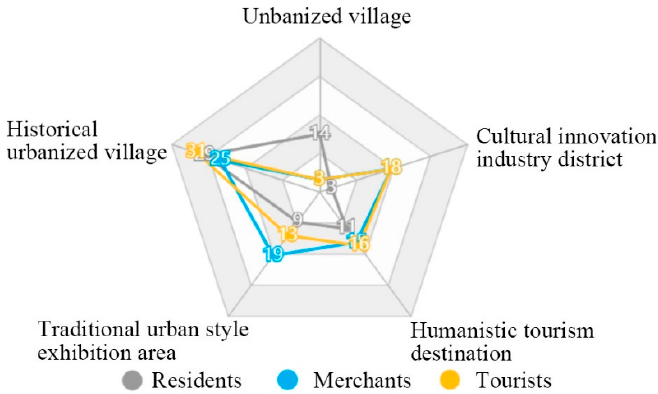
Figure 5. Cognitive analysis of the positioning of Nantou Ancient City by the multi public.